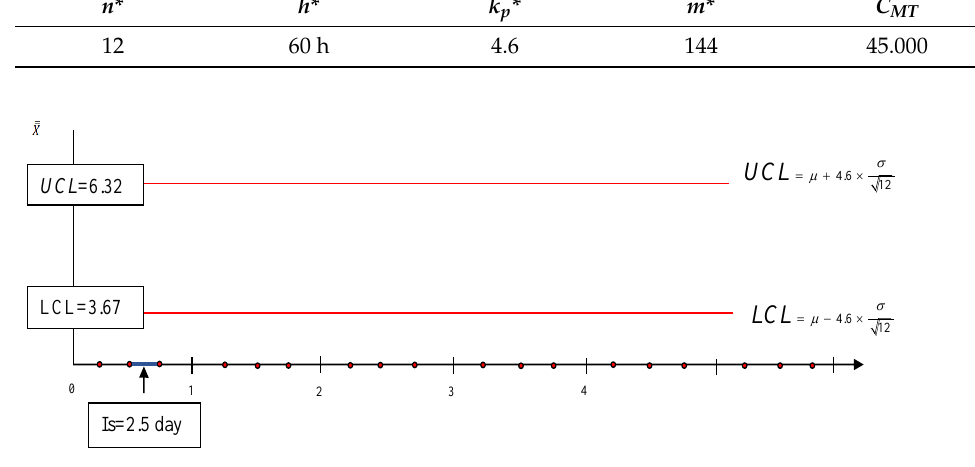
Figure 8. Control chart parameters.